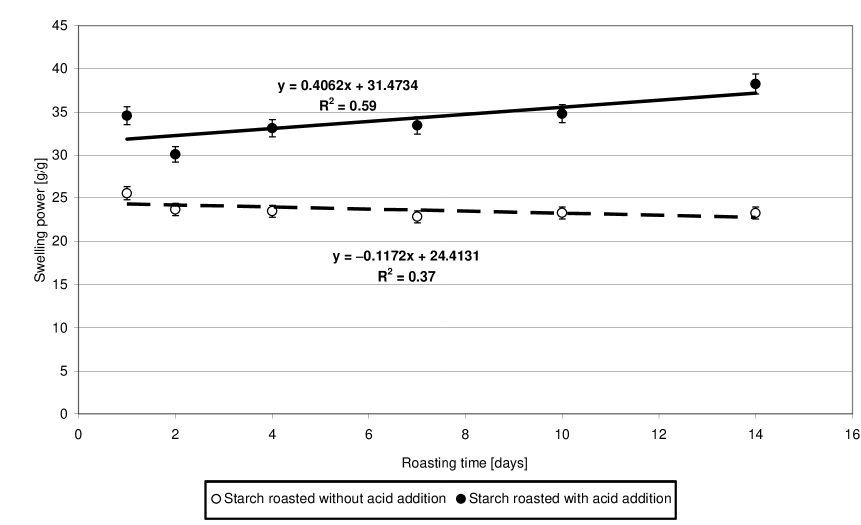
Figure 4. Dependency of swelling power on the time of starch retention with and without citric acid.